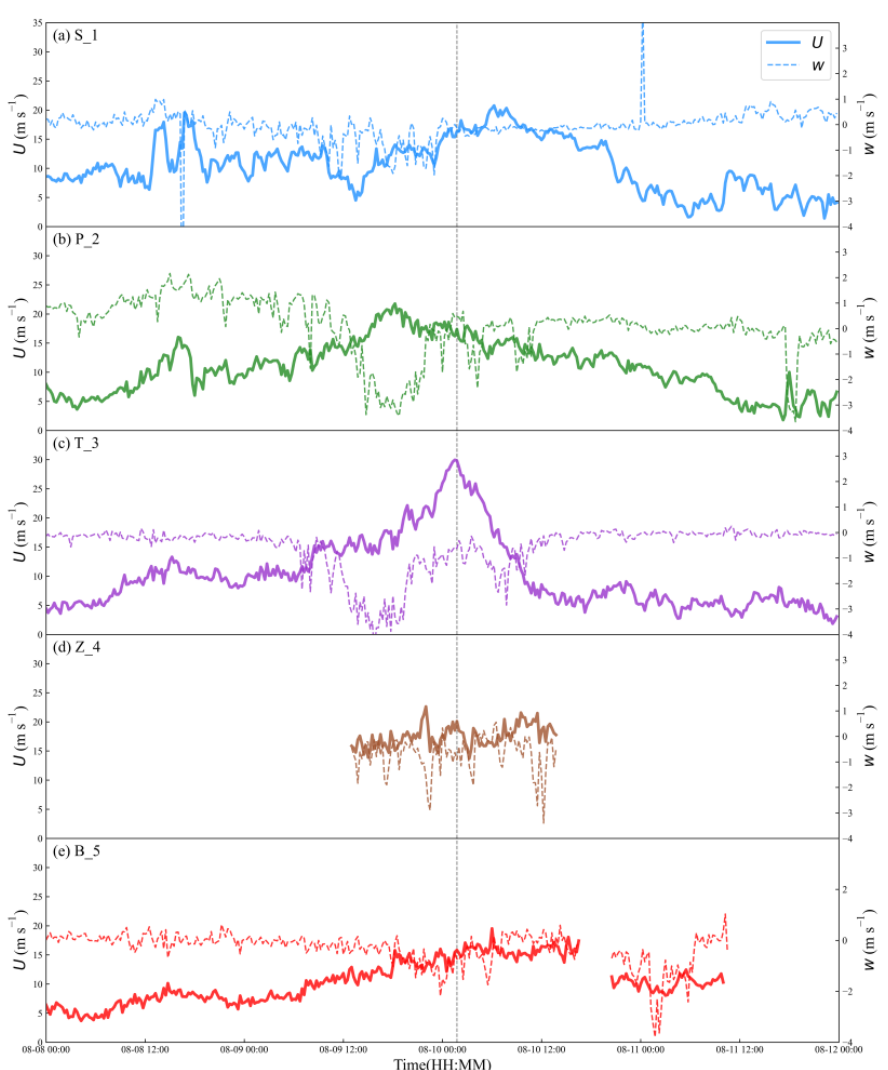
Figure 5. Changes of U and w with time at the same height for the five DWLs, where U is shown as a solid line and w is shown as a dashed line. ( a ) S_1, ( b ) P_2, ( c ) T_3, ( d ) Z_4, and ( e ) B_5. S_1 (Figure 5a) showed a decrease and then increase in U from 6:00 to 18:00 on 9 August, and the U decreased to its lowest at around 12:00 on 9 August. This is